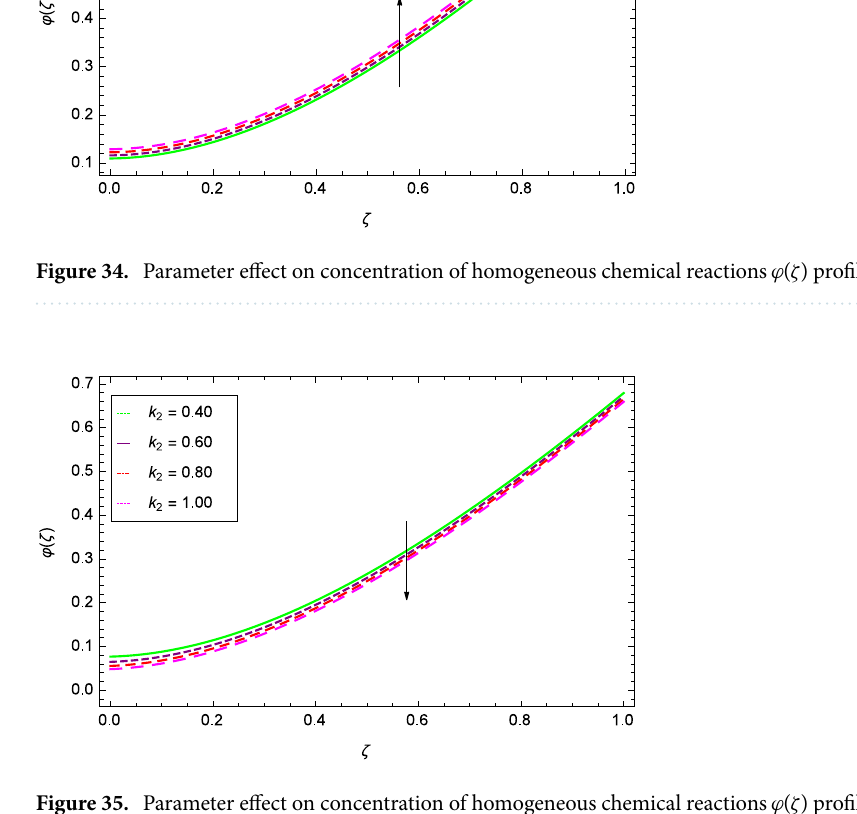
Figure 35. Parameter effect on concentration of homogeneous chemical reactions ϕ ( ζ )